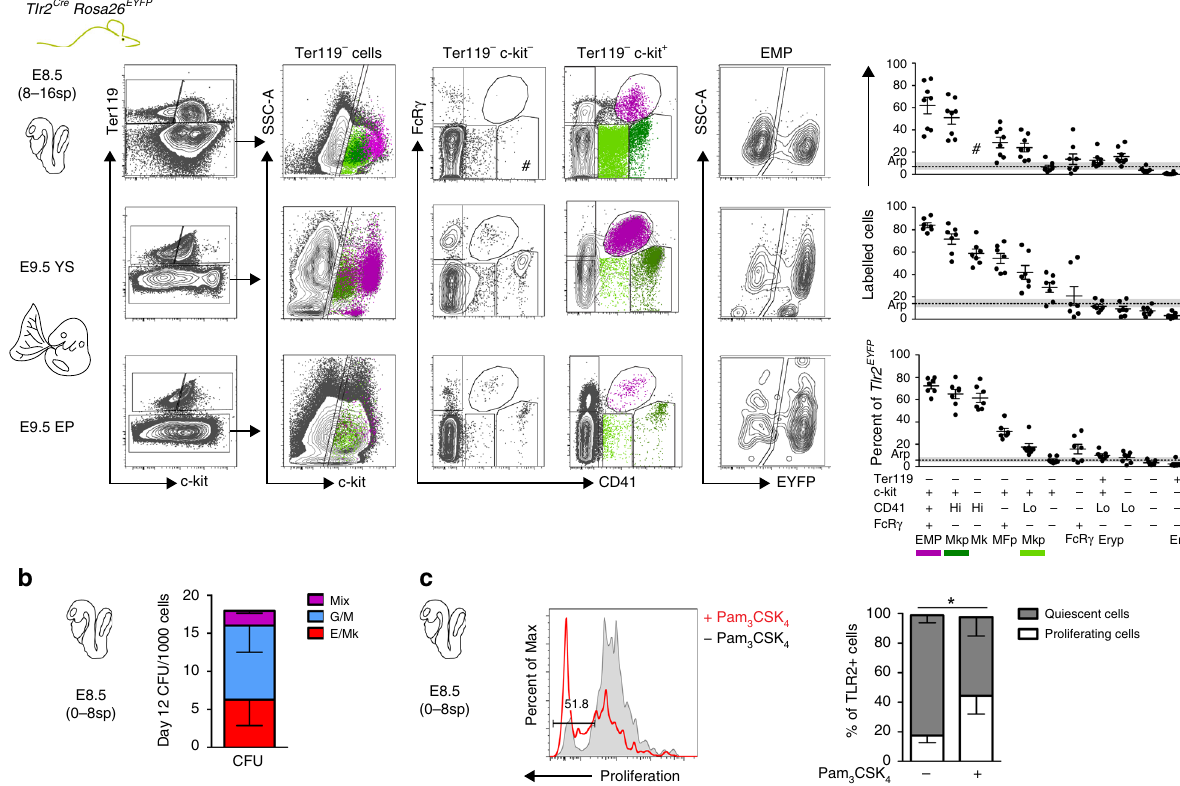
Fig. 3 Lineage tracing shows activation of Tlr2 locus predominantly in EMPs. a Embryonic hematopoietic precursors were analyzed by FCM for frequency of labeling in E8.5 and E9.5 Tlr2 Cre Rosa26 EYFP embryos (mean ± SEM; n = 7 – 9; arp, average recombination probability is equal to mean ± SEM (gray zone) labeling ef fi ciency of all live cells; EMP, erythro-myeloid progenitor; Mkp, megakaryocyte progenitor; Mk, megakaryocyte; MFp, macrophage progenitor; FcR γ , FcR γ + cells; Eryp, Ery progenitor; EryP, primitive erythrocyte; # insuf fi cient cell count for statistical analysis). b Sorted E8.5 Tlr2 Cre EYFP + Lin −